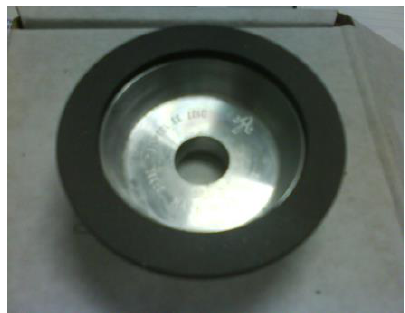
Figure 2: Diamond cup wheel 75 x 10 x 3 x 16mm bore